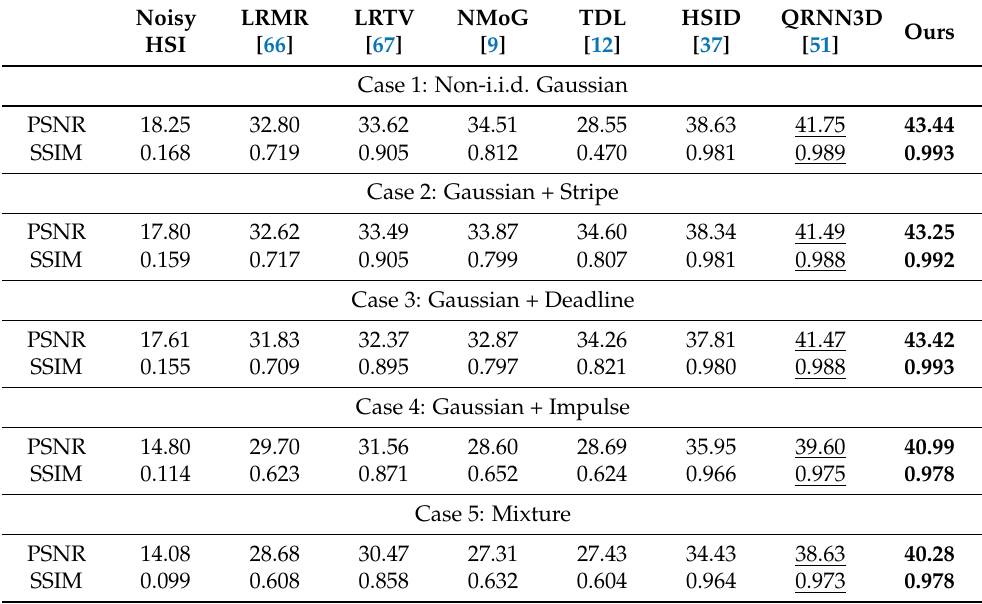
Figure 12. Visual results of competing denoising methods on Pavia University dataset. Table 1. Quantitative results of different methods in five complex noise cases on ICVL dataset. Best and second best scores are highlighted and